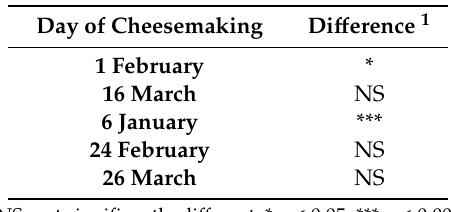
Table 4. Results of the triangular test made on cheese samples at 30 days’